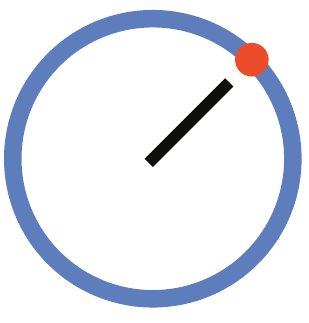
Figure 5. Rotational invariance and natural metrics. A circle expresses a rotationally invariant radial distance from a central location. A natural metric can be thought of as a measure of radial distance. Different component observations that add to the same radial distance define a rotationally invariant